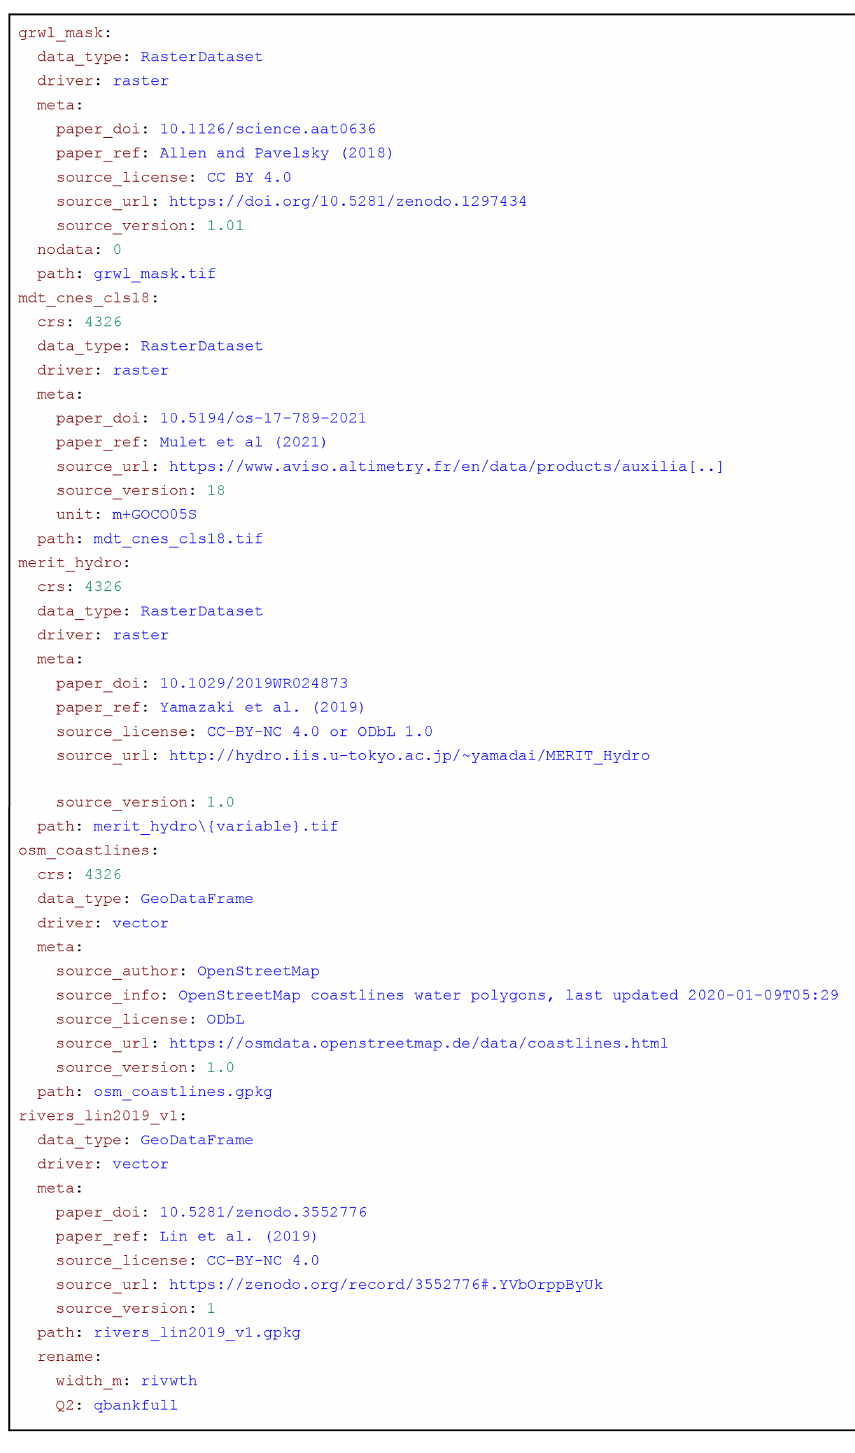
Figure B2. Data catalog (.yaml) file used to set up the SFINCS model schematization (see Sect. 3.2.1). Each entry corresponds to a dataset and contains information about how to read it and which preprocessing steps (such as renaming) are